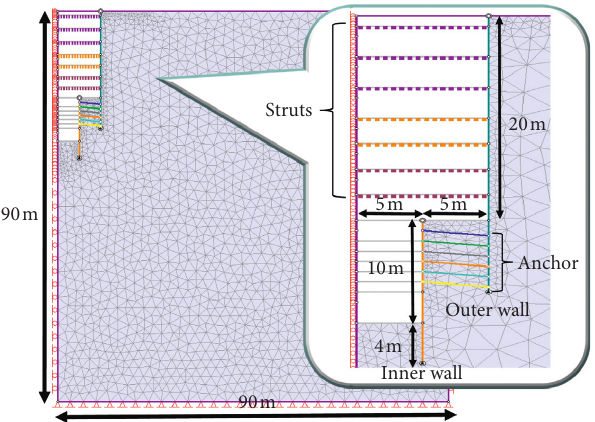
Figure 4: Geometry of earth stepped-twin retaining wall. Table 1: Physical and mechanical properties of joint